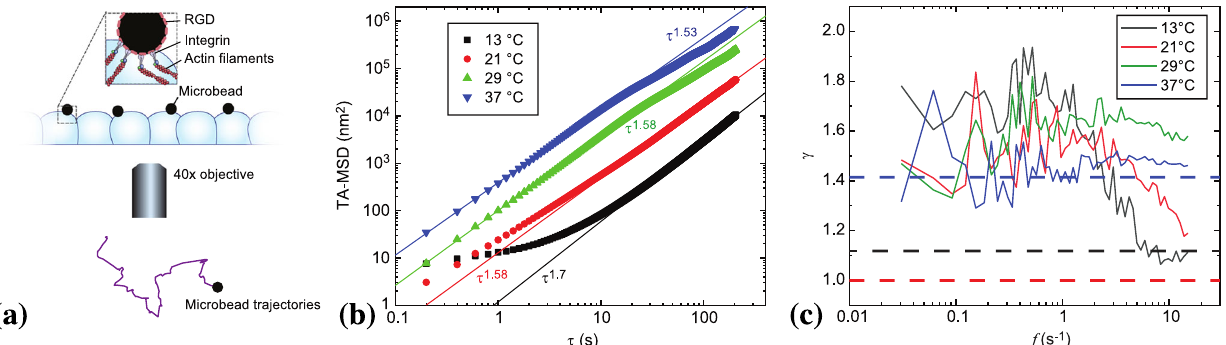
Fig. 5 Cytoskeleton fl uctuations of living cells exhibit superdiffusive behaviour. a Sketch of the experimental system for microbeads attached to the surface of epithelial cells (see the “ Experiments" subsection in the “ Methods ” section for more details) together with a representative experimental trajectory. b MSD at varying temperatures. The straight lines show that the dynamics are superdiffusive with 2 H between 1.5 and 1.7, depending on temperature. c Coef fi cient of variation of the power spectrum of the motion of the surface-bound microbeads. The dashed lines indicate γ = 1, p 2 , the predicted limiting values of γ for the different diffusion regimes, in the absence of any